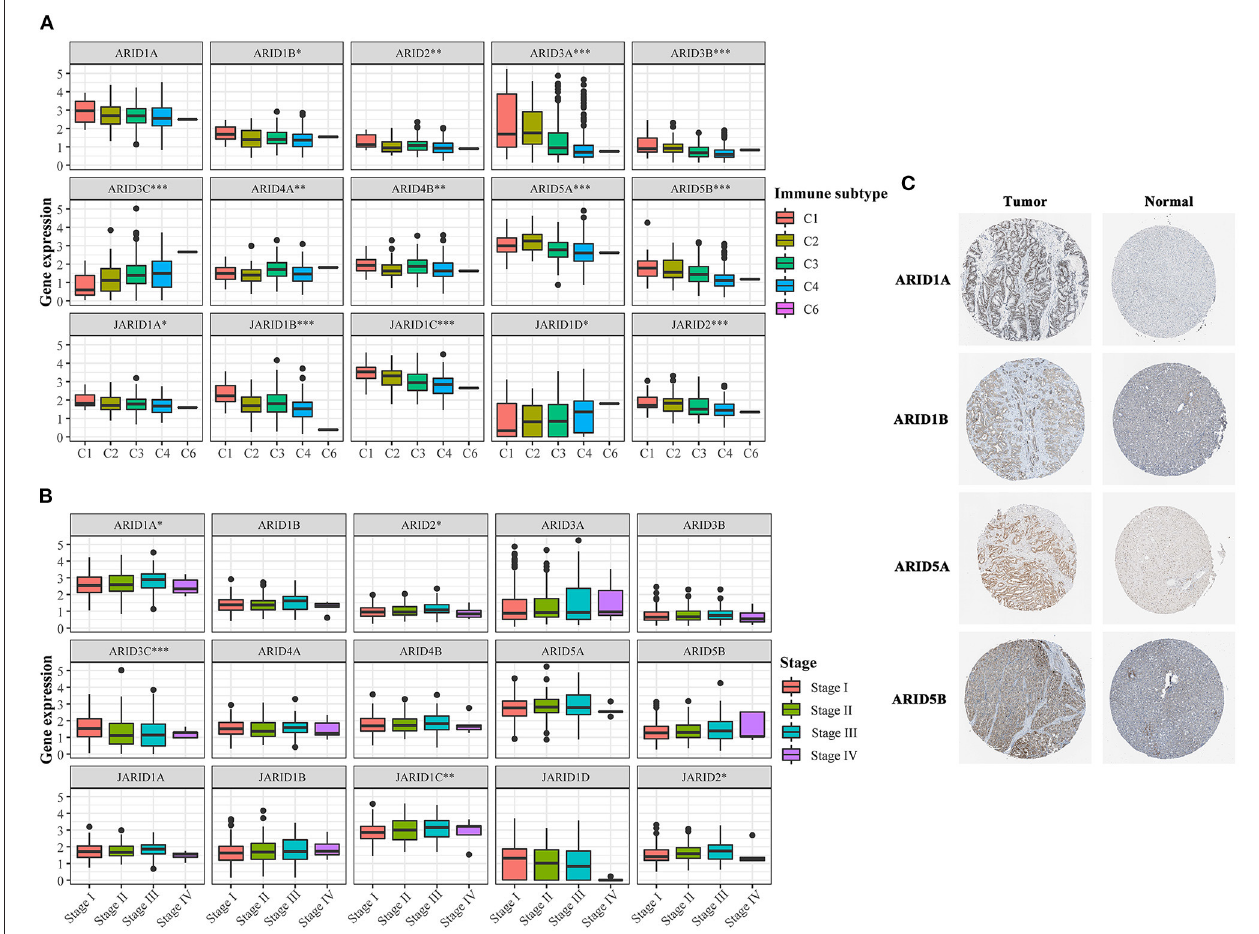
FIGURE 5 | ARID family expressions in LIHC. (A) Association of ARIDs expression with immune infiltrate subtypes in LIHC. (B) Association of ARIDs expression with TNM stage in LIHC. (C) The protein level of the genes in HPA database. * P < 0.05, ** P < 0.01, *** P <